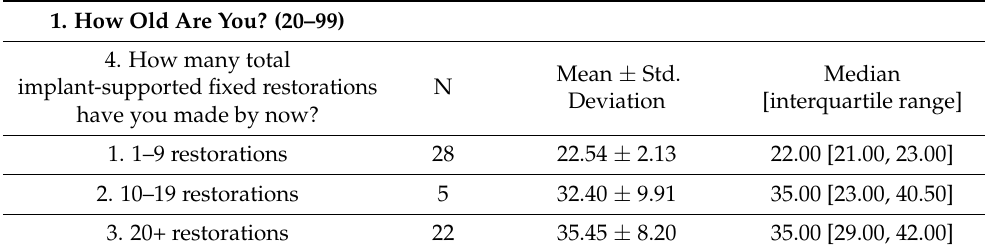
Table 2. Test: Kruskal-Wallis H, p value = 0.000002 (general significant difference–between the three groups), postdoc tests (we are searching for differences between pears of two groups): p -value = 0.000 (between 1. 1–9 restorations and 3. 20+